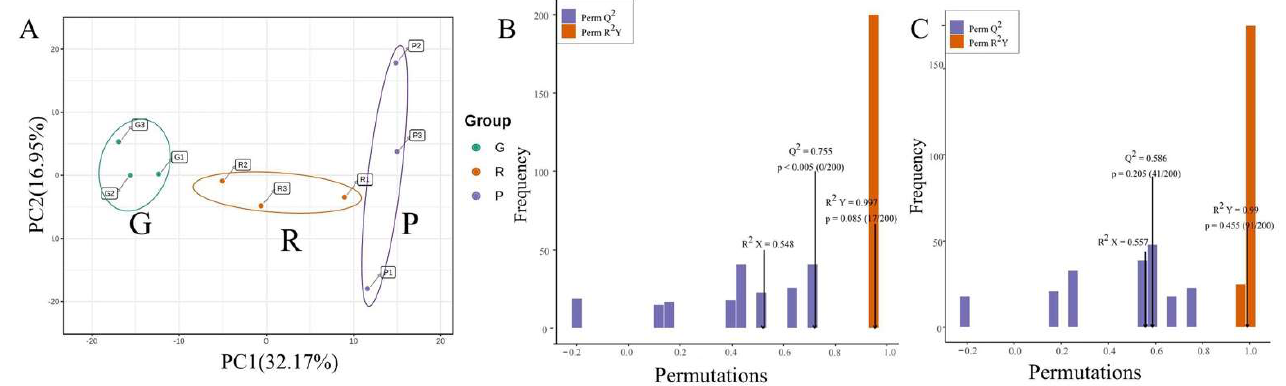
Figure 2. ( A ) PCA score plot of the metabolites in different ripening stages of rose hips. ( B ) OPLS-DA analyses of Green hips and Red hips. ( C ) OPLS-DA analyses of Red hips and Purple hips. Note: G: green hips, unripe; R: red hips, half ripe; P: purple hips, fully ripe.